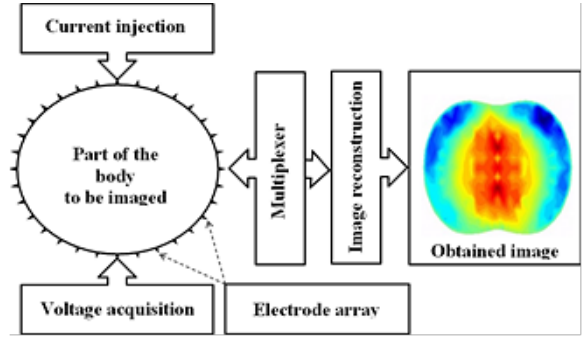
Fig. 2: Main parts of an EIT imaging